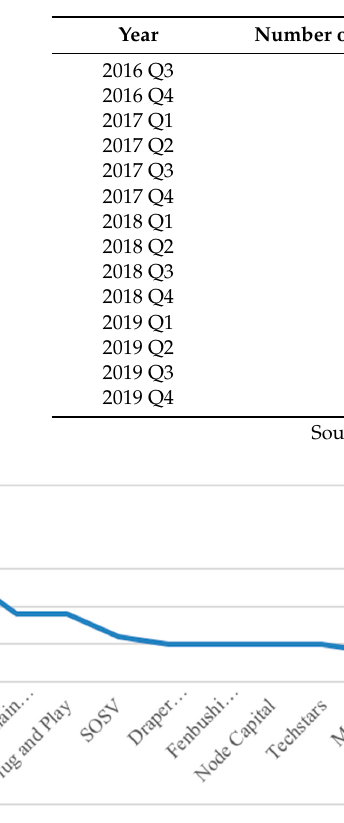
Figure 7. Venture round count completed by key investors of blockchain between 2017 and end of February 2018. Source: CB insights, PwC, ICO Insights and Token Data. Int. J. Financial Stud. 2020 , 8 , x FOR PEER REVIEW